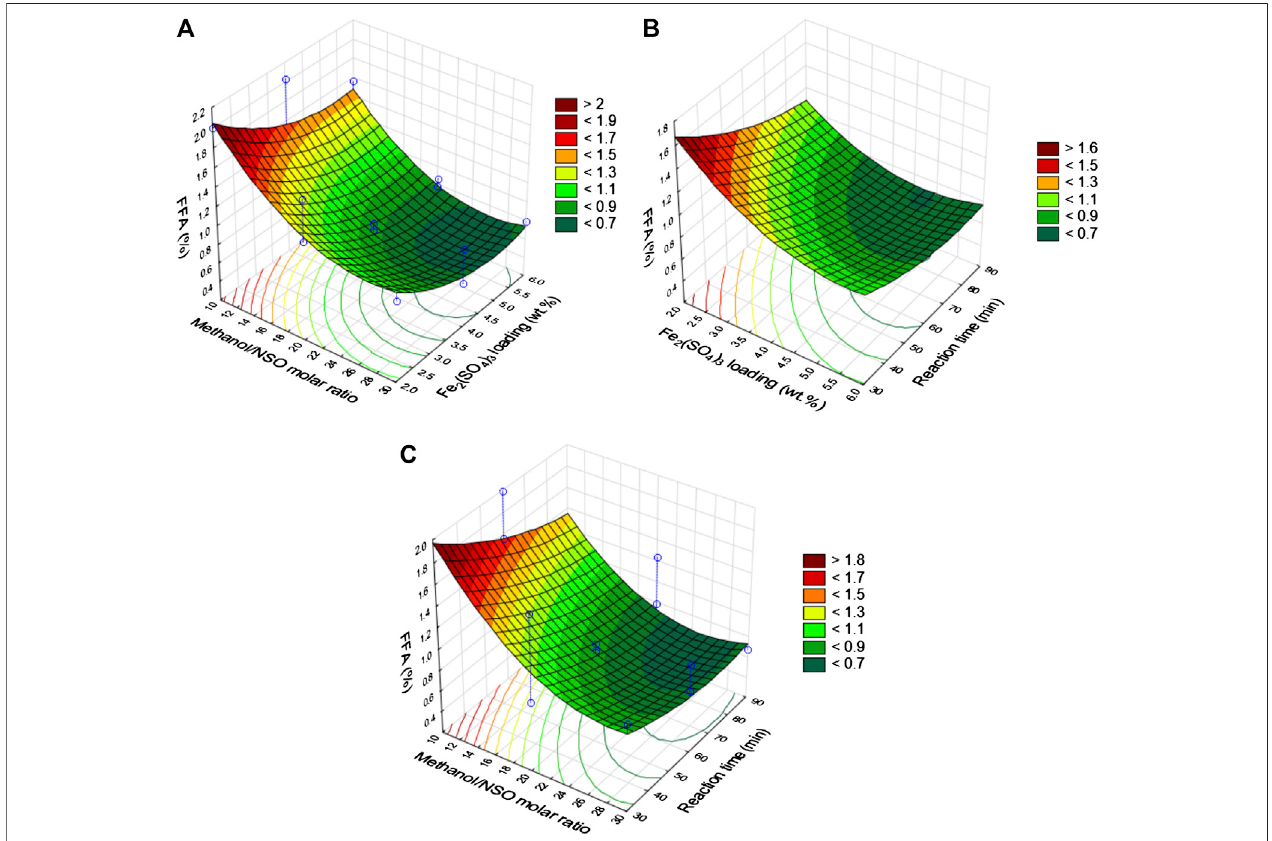
FIGURE5| ResponsesurfaceplotsforNSOesteri fi cationprocess. (A) methanolNSOmolarratiovs.catalystloading; (B) catalystloadingvs.reactiontimeand (C) methanol NSO molar ratio vs. reaction time.